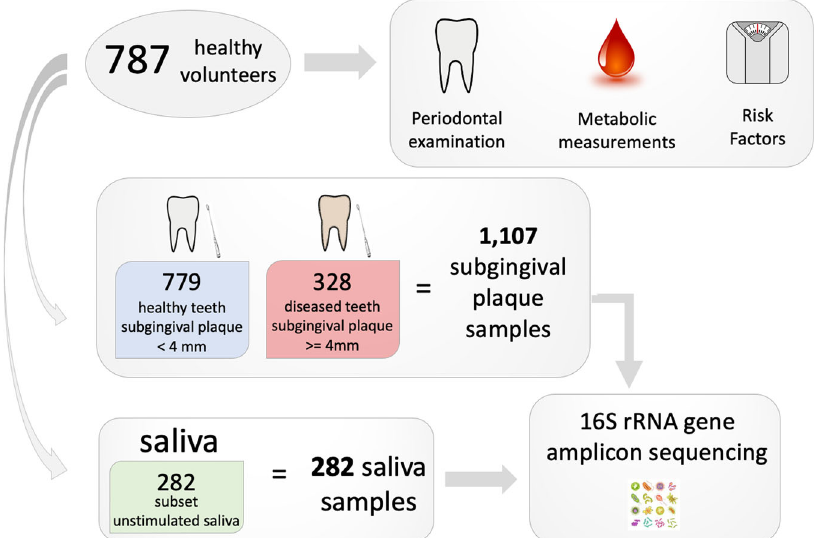
Fig. 1 Experimental design. 787 healthy volunteers were recruited to participate in the ORIGINS project. Each participant underwent an extensive periodontal examination, metabolic assessment, and completed standard questionnaires assessing demographic and risk factor information. Subgingival plaque samples were collected from teeth with periodontal pockets <4 mm depth (healthy) and teeth with periodontal pockets ≥ 4 mm depth (diseased) where applicable. In parallel, unstimulated saliva were collected and processed for a subset of individuals. In total, 16 S rRNA gene amplicon sequencing data from 1107 subgingival plaque samples and 282 saliva samples was generated for